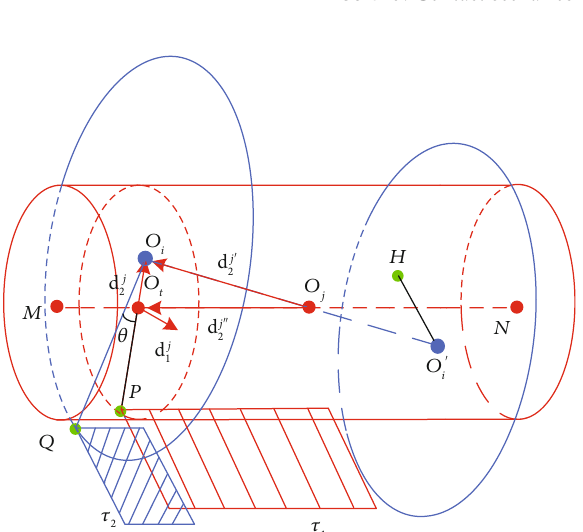
Figure 4: Mathematical model of radial distance of revolute joint with 3D clearance.